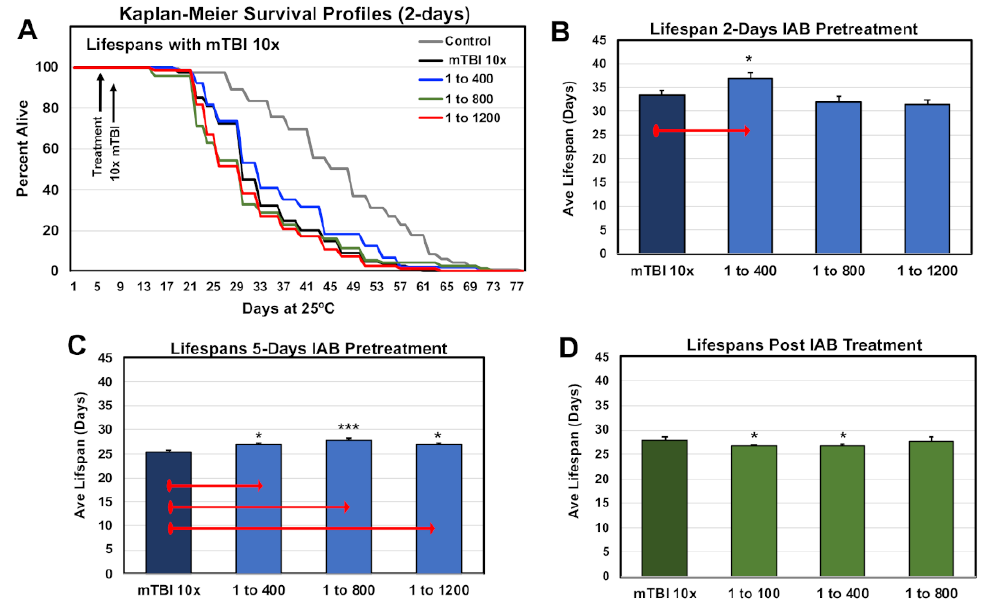
Figure 4. Impact of biological treatment on the longevity profiles of traumatized Drosophila . ( A ) The Kaplan–Meier Survival profiles of male flies pre-treated (two days) with different IAB dosages. ( B – D ) Average lifespan profiles of fly cohorts pre-treated for ( B ) two days or ( C ) five days before mTBI-10 × exposure, and ( D ) post-treated profiles. (* p -values <0.5, *** p -values < 0.001). See Supplementary Table S3A–C for fly numbers (n) and additional